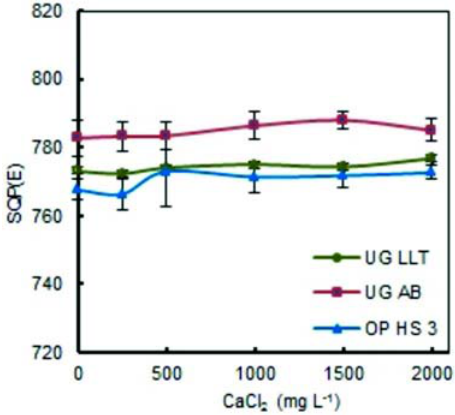
Figure 2. Relationship between SQP(E) value and total dissolved salt amount, CaCl at 14:6 scintillation deionized water 2